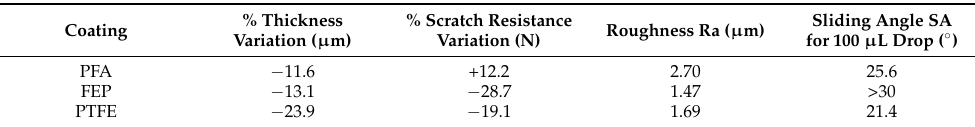
Table 3. Variation in the properties of the coatings between the initial state and after 4 s of wear via projection with brown corundum particles (CM).